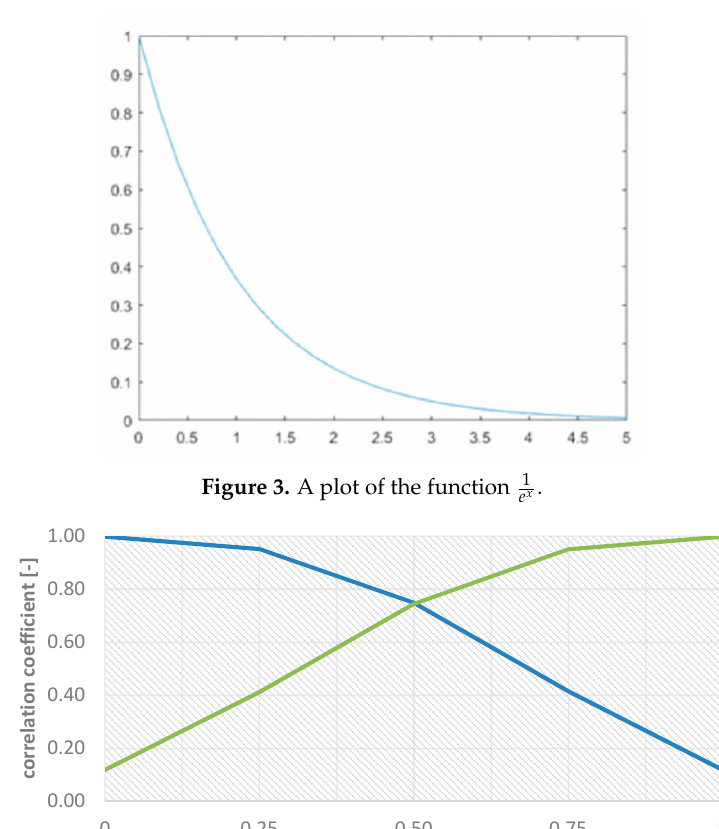
Figure 4. The correlation coefficient between the modified panchromatic image and the original panchromatic image (marked in blue) and the correlation coefficient between the modified panchromatic image and the intensity of the multispectral image (marked in green).